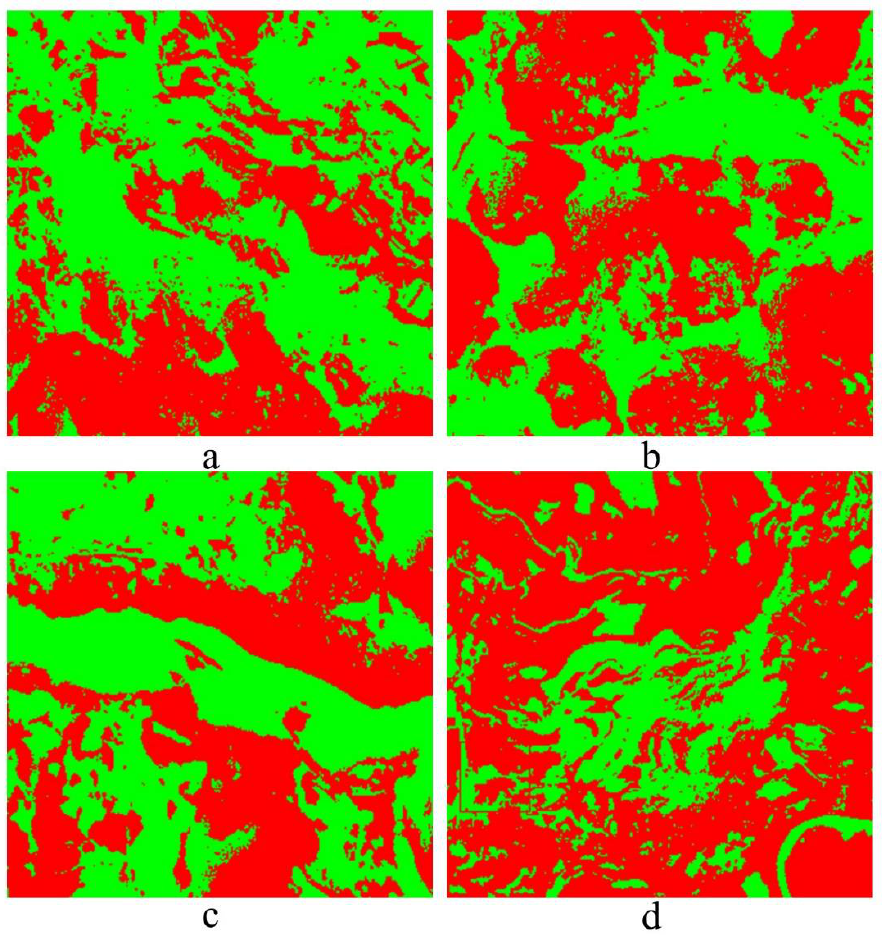
Figure 25. Areas a – d .